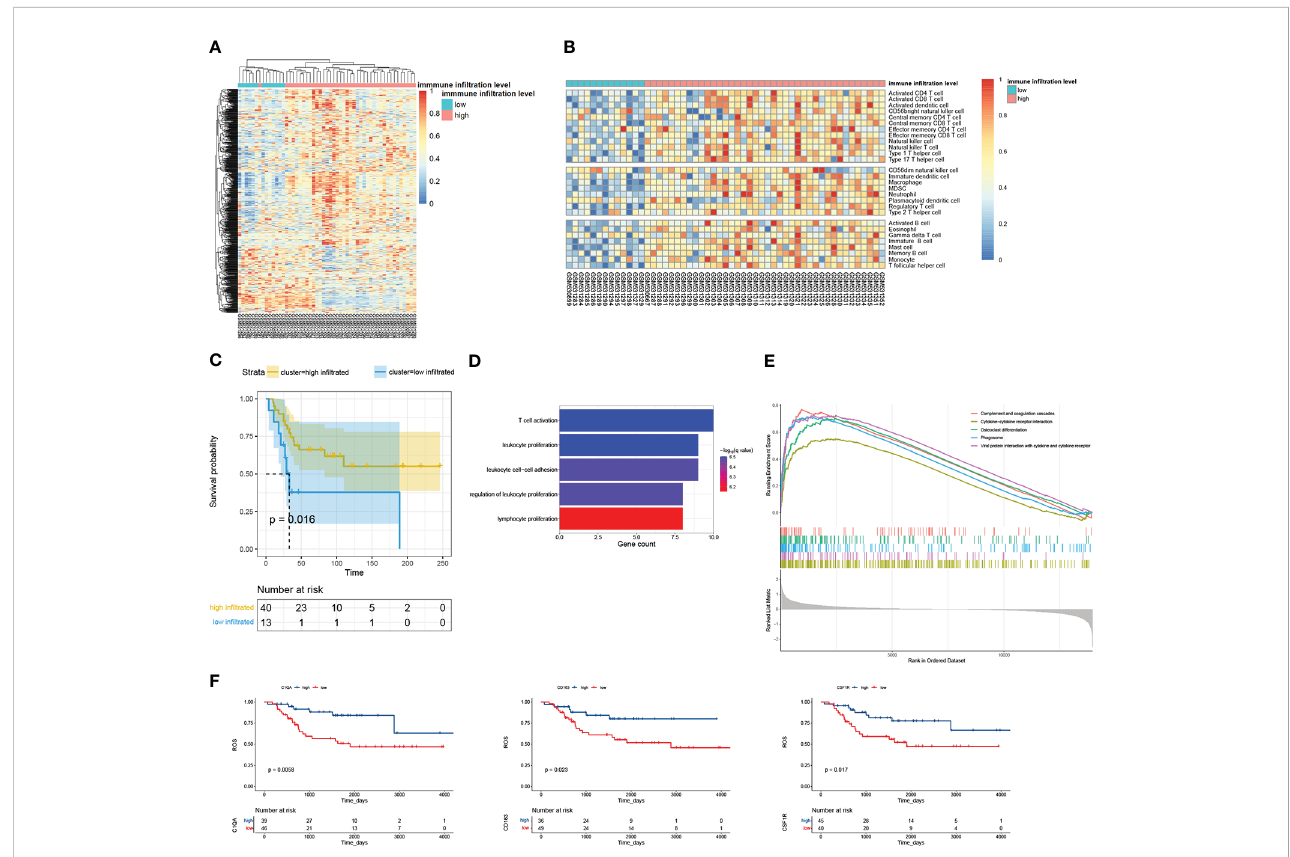
FIGURE 2 The overview of analyzing GSE21257. (A) There were 53 examples clustered into two groups by immune metagenes. (B) The score of 28 kinds of immune cells calculated by ssGSEA. The 53 examples were ordered by their immune groups instead of getting clustered. (C) The survival plot of high- and low- immune in fi ltrated groups. (D) Biological process enrichment of the 34 overlapped DEGs. (E) GSEA of the 34 overlapped genes; the top 5 terms were selected. All p-values are 1e-10, and all p.adjust are 1.447826e-09. (F) The survival plot of overlapped